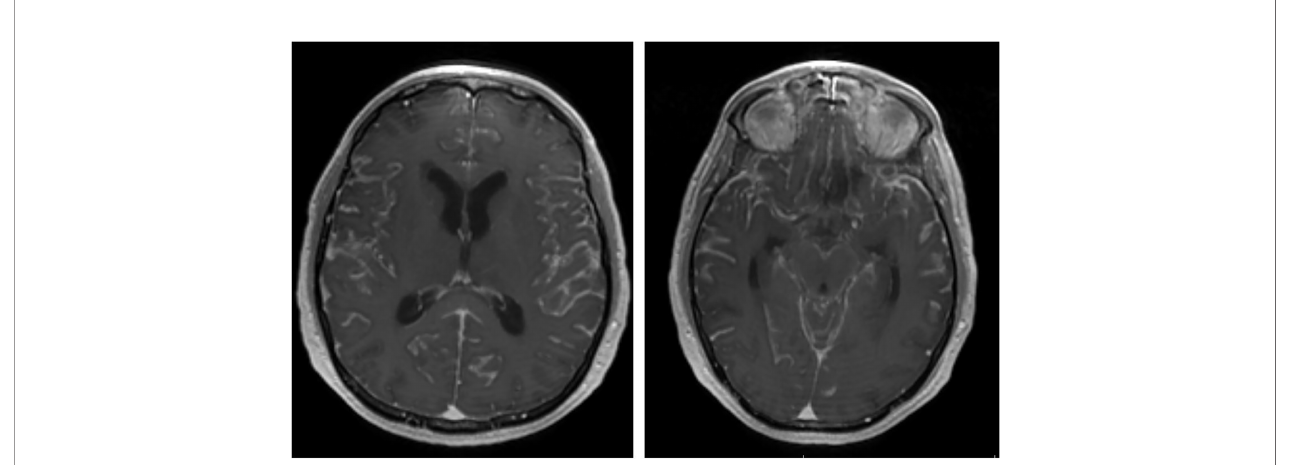
FIGURE 1 | Representative post-contrast brain MRI (axial) showing diffuse LMD with enhancement within the cerebral